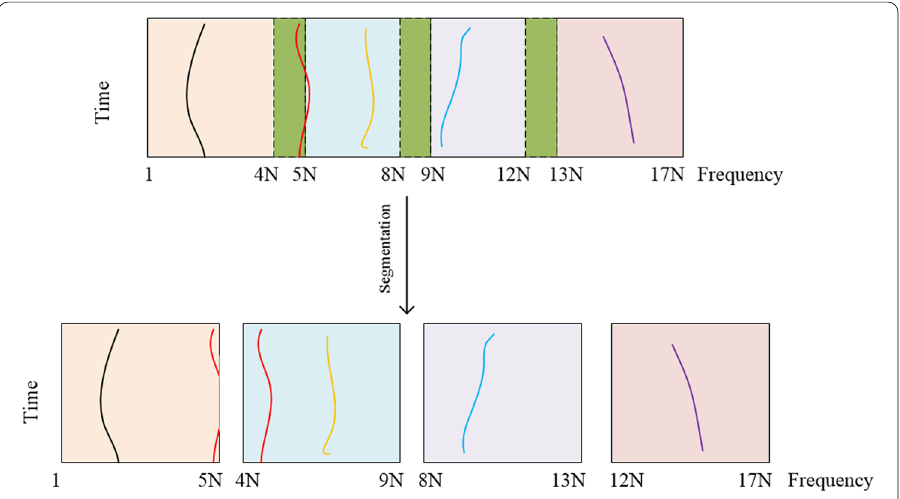
Fig. 3 Segmentation of